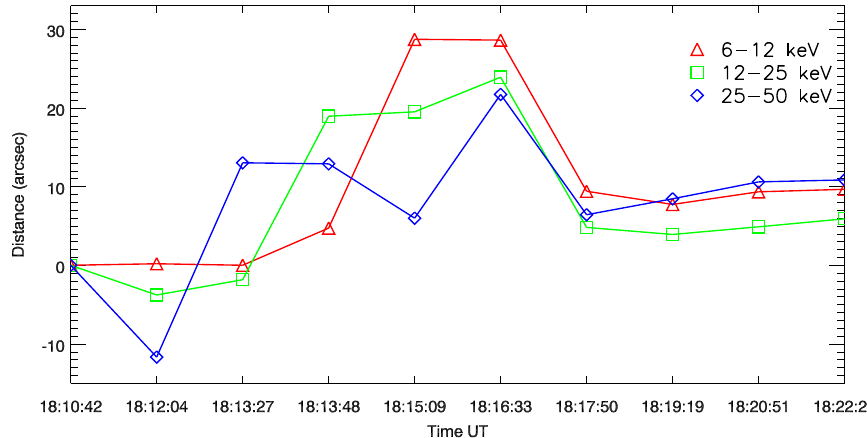
Figure 4. The time evolution of the distance between RHESSI X-ray sources at 18:10:42 UT and that at other